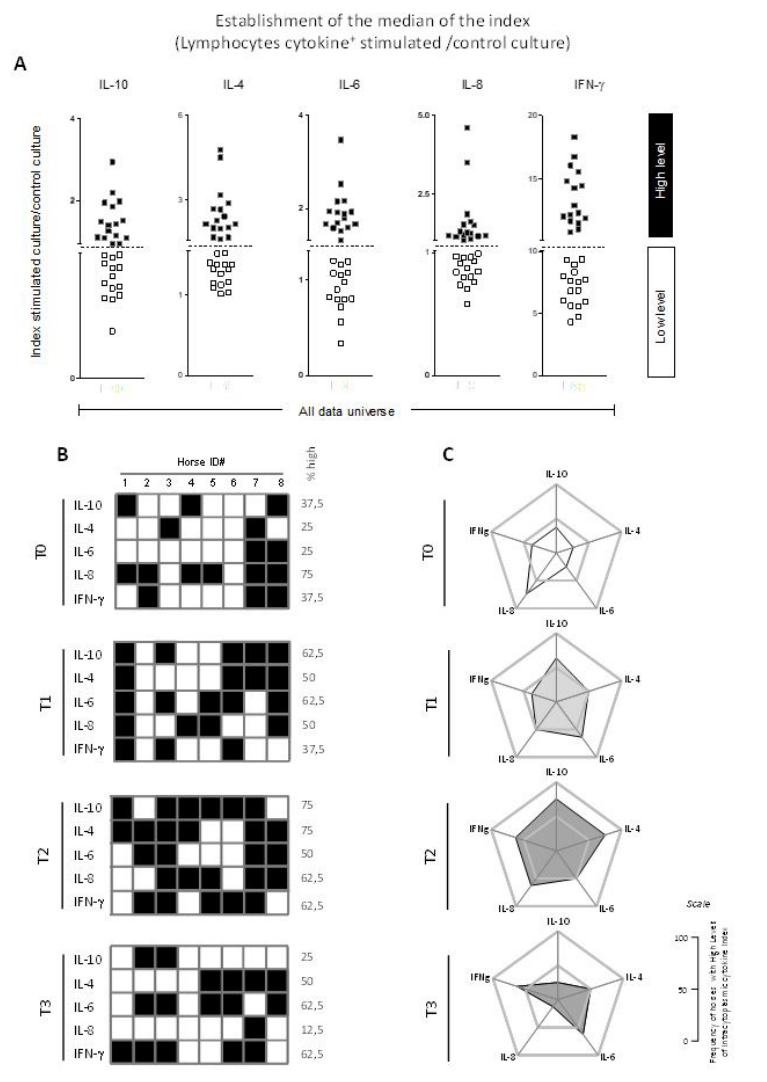
Figure 2. Signature analysis of the intracytoplasmic cytokines in lymphocytes from peripheral blood samples of the horses submitted to autohemotherapy (AHT) after the cells were cultured in vitro under PMA stimulation. (A) Representative scatter graphs employed to establish global median cut-off edges of the indices (Lymphocyte’s cytokine + stimulated/control culture) of each cytokine (IL-10, IL-4, IL-6, IL-8, and IFN- γ ) used to segregate horses that presented “Low” ( □ ) or “High” ( ■ )cytokine index levels; (B) Black-scale diagrams used to compile the frequency (%) of high cytokine producers. (C) Radar chart graph with cytokine indices for each occurrence after AHT (T0, T1, T2, and T3). “High cytokine producers” were considered relevant when frequencies were above the 50th percentile. The results are expressed as the proportion of horses with plasmatic cytokine levels above the global